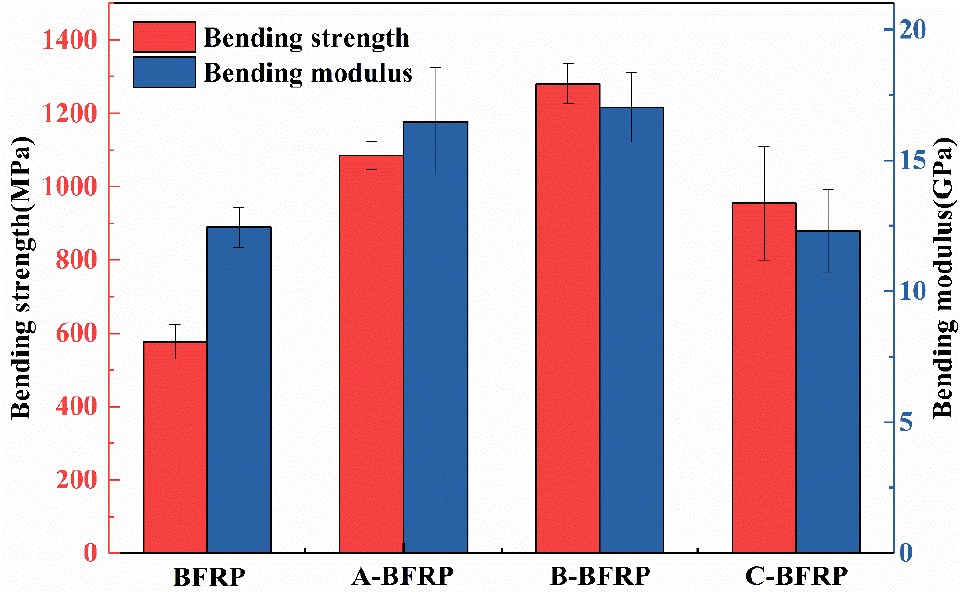
Figure 2. Bending properties of basalt fiber/epoxy resin composites.